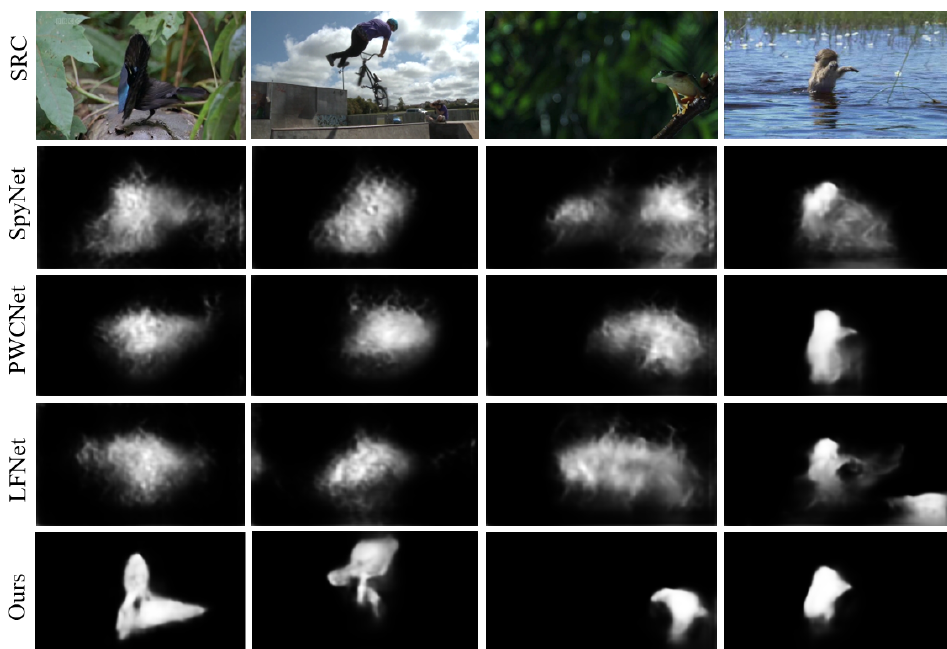
Figure 6. Comparison of motion saliency maps generated by four different optical flow models, with “Ours” representing the motion saliency map generated by the optical flow model proposed in this